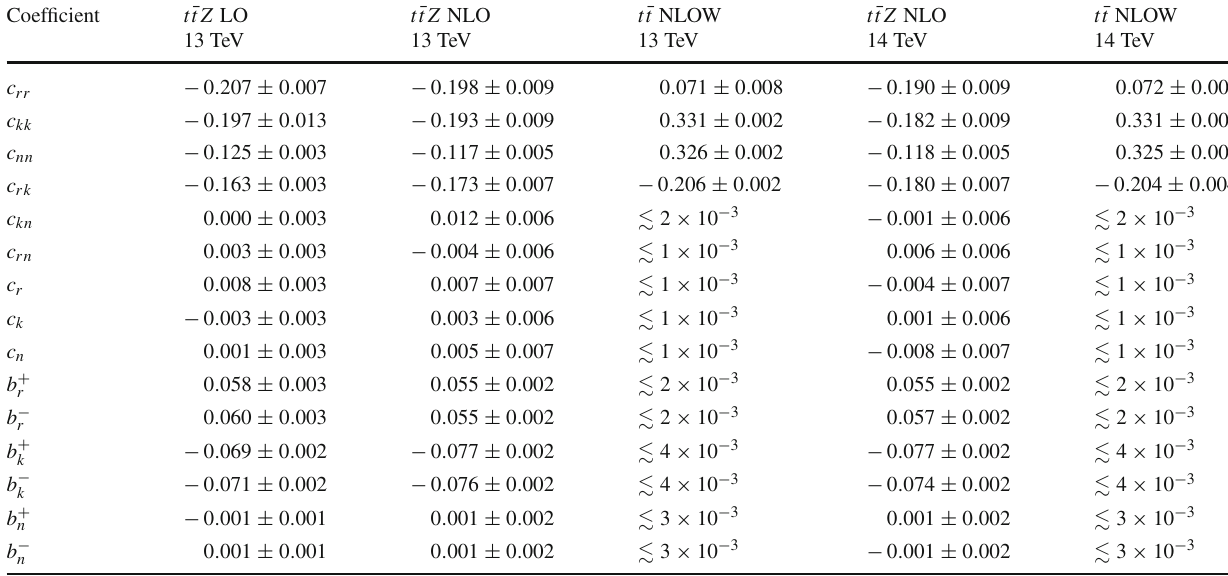
the Monte Carlo statistical uncertainties and variations of the scales (as described in the text). The fourth and sixth columns display the results ofasimilarcalculationin t ¯ t eventsatmixedNLOQCDandelectroweak precision (“NLOW"); these numbers are quoted from Ref.